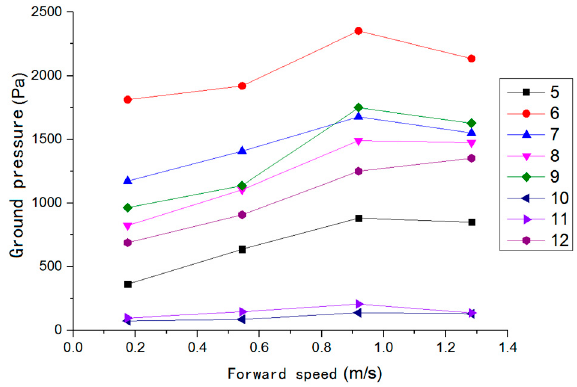
Figure 15. Relationship between ground pressure and forward speed.